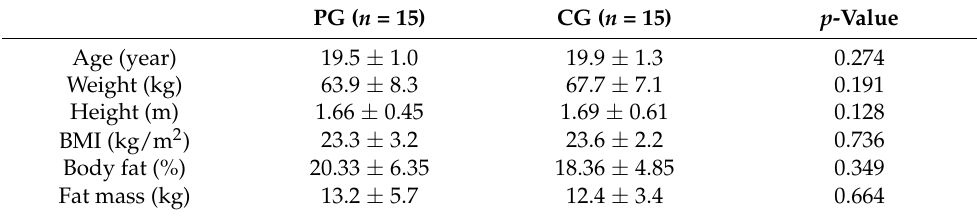
Table 1. Physical characteristic and body composition of PG and CG at the baseline.